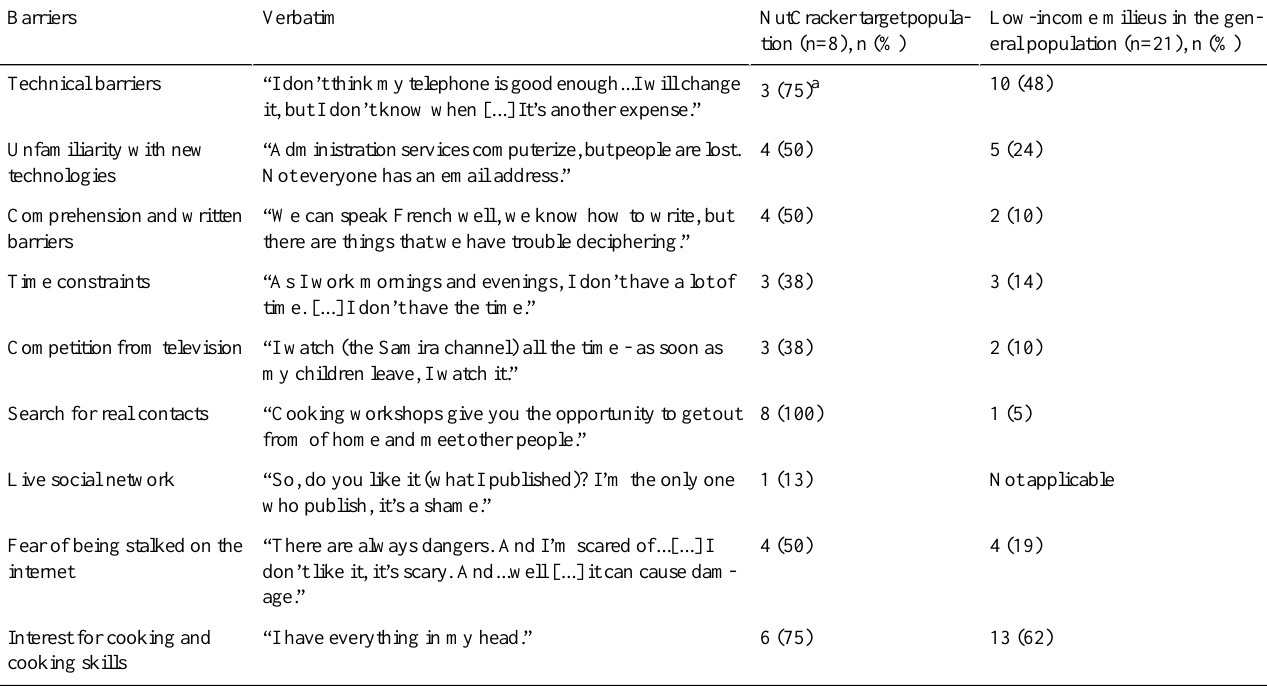
Table 3. Barriers to using NutCracker and the new technologies by the Nutcracker sample and the low-income milieu population.